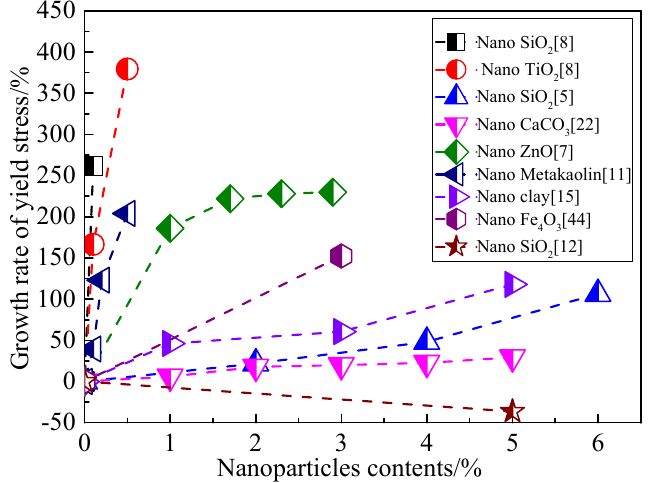
Figure 8. The relationship between the growth rate of yield stress and the content of nanoparticles [5,7,8,11,12,15,22,44]. cles